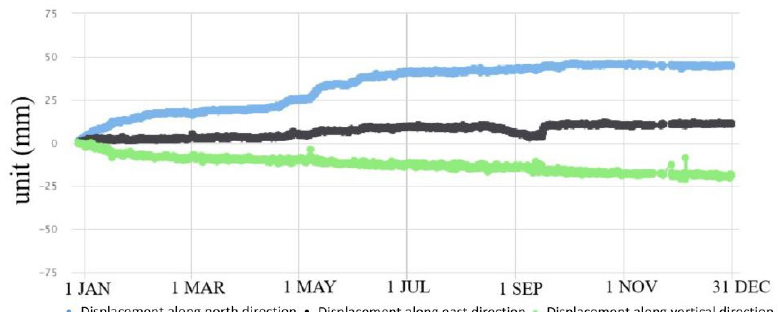
Figure 7. Displacements recorded by GPS 04 in 2016.